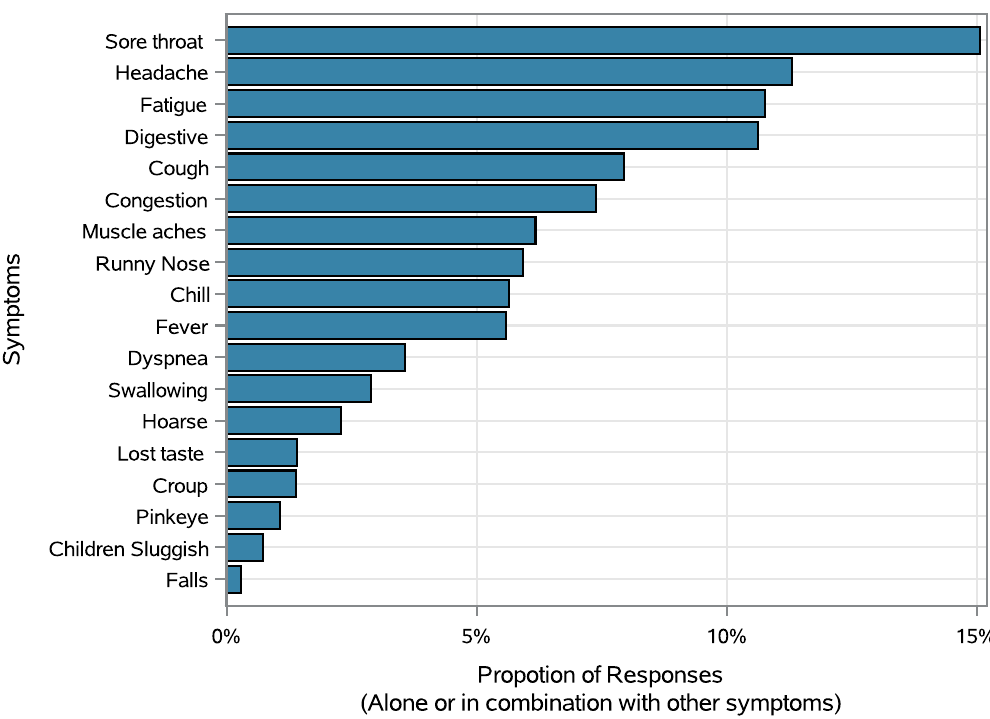
Figure 9. Frequency of COVID-19 related symptoms reported on the portal.